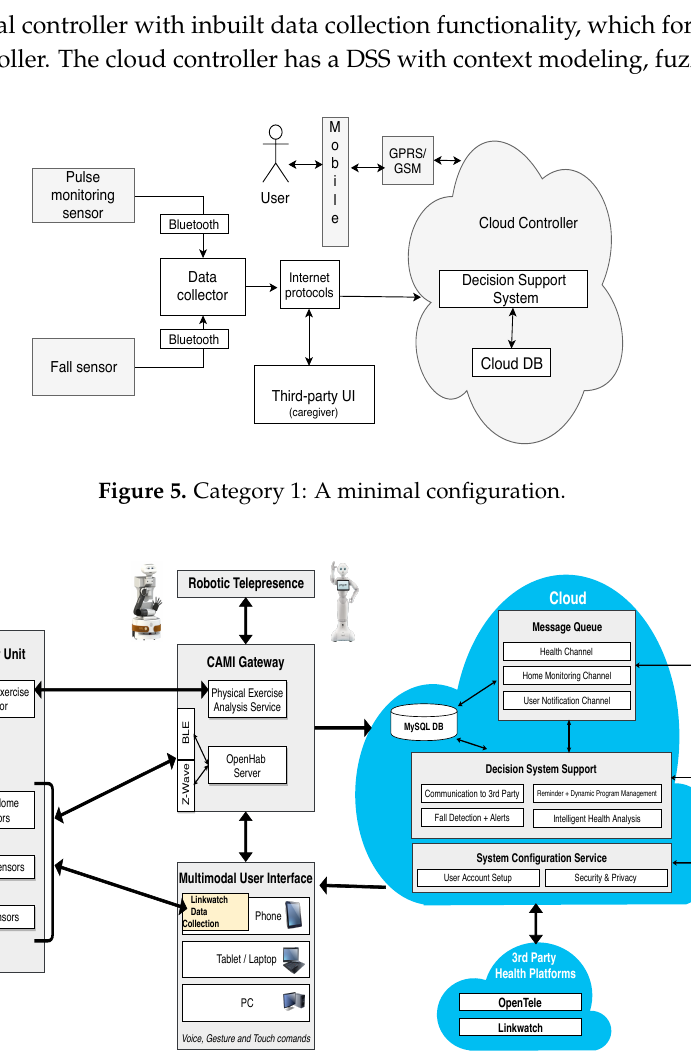
Figure 6. Category 2: An intermediate